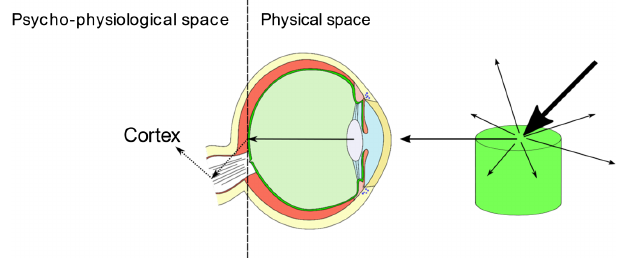
FIG. 5. Mechanism of vision from physical and psycho- physiological points of view. The process of human vision is divided into two parts: the physical and the psycho-physiological part. The physical part integrates propagation of light, scattering, and image formation. The path of light runs from the light source (sender) via the perceived object to the retina (receiver). In the psycho-physiological part, the cerebral interpretation of the effects of the light on the retina takes place